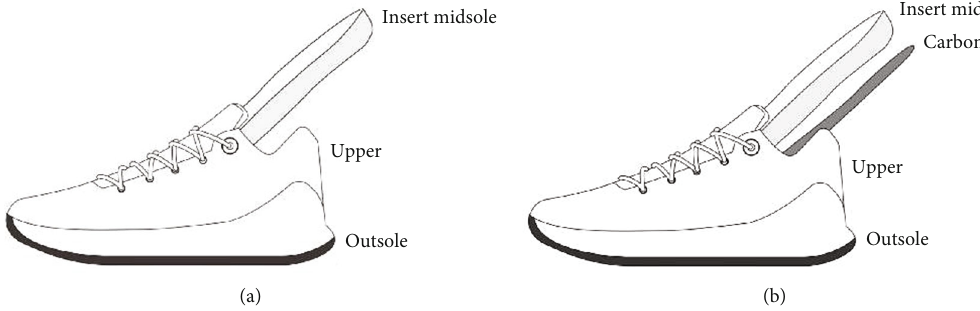
Figure 1: Schematic diagram of shoe conditions: (a) control shoe; (b) sti ff shoe.